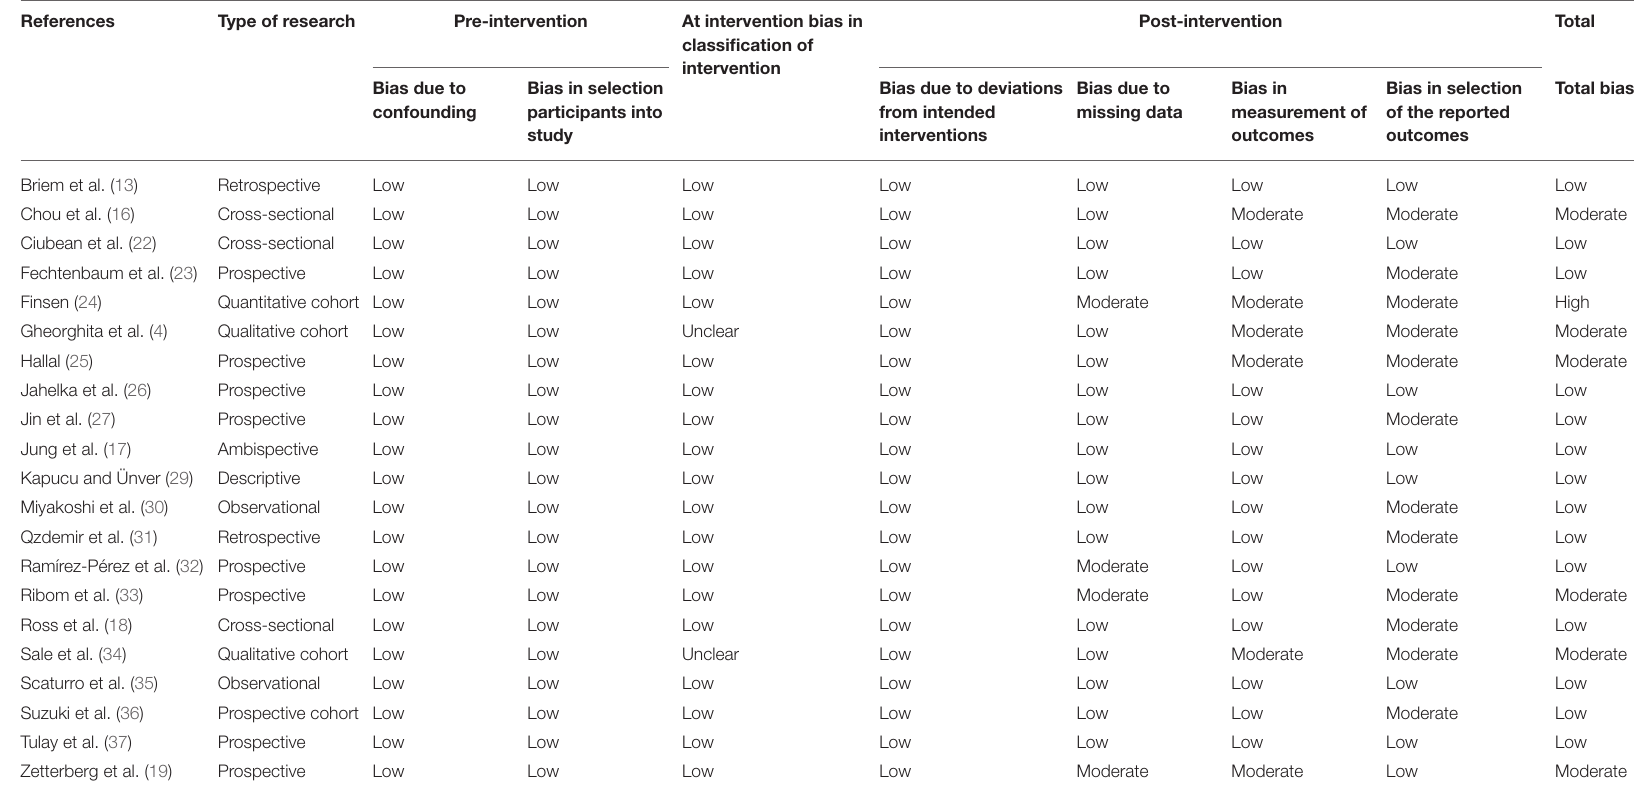
TABLE 3 | Risk of bias assessment using